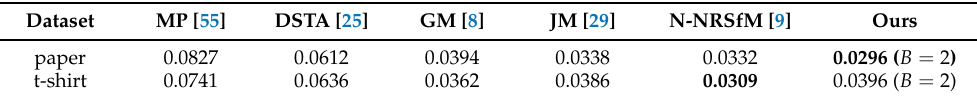
Table 5. e 3 D on the Kinect paper and t-shirt sequences.